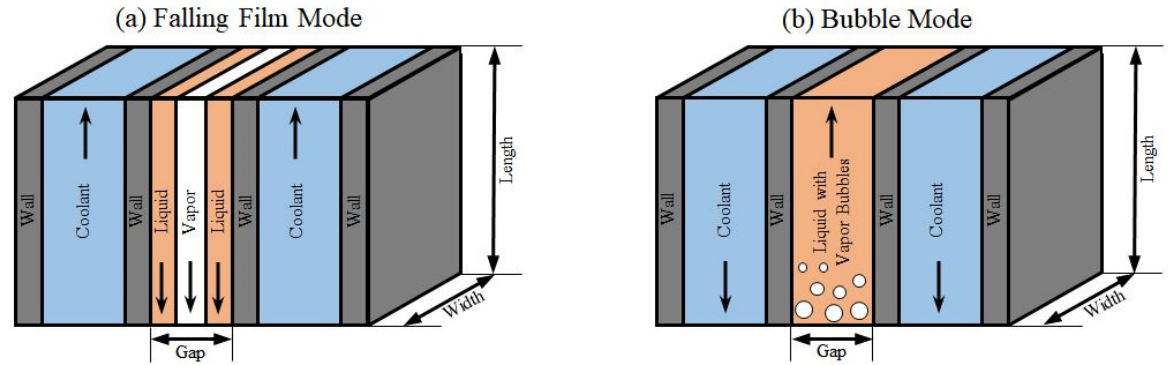
Figure 5. Schematic representation of a plate heat exchanger operated as absorber in ( a ) falling film and ( b ) bubble mode (adapted from Ahrens et al. (2019) [75]).